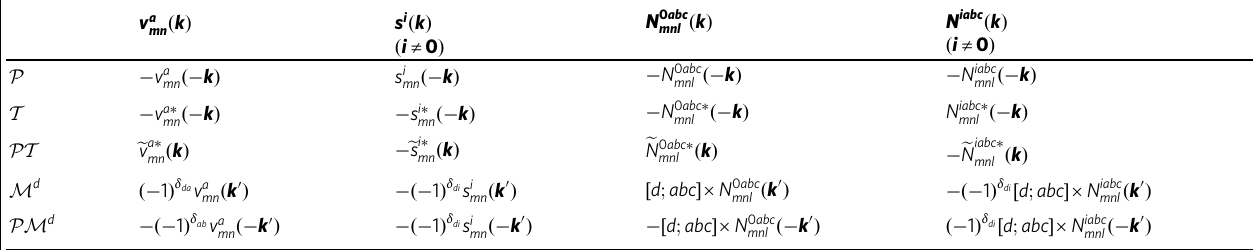
Table 1 The behavior of physical quantities under symmetry